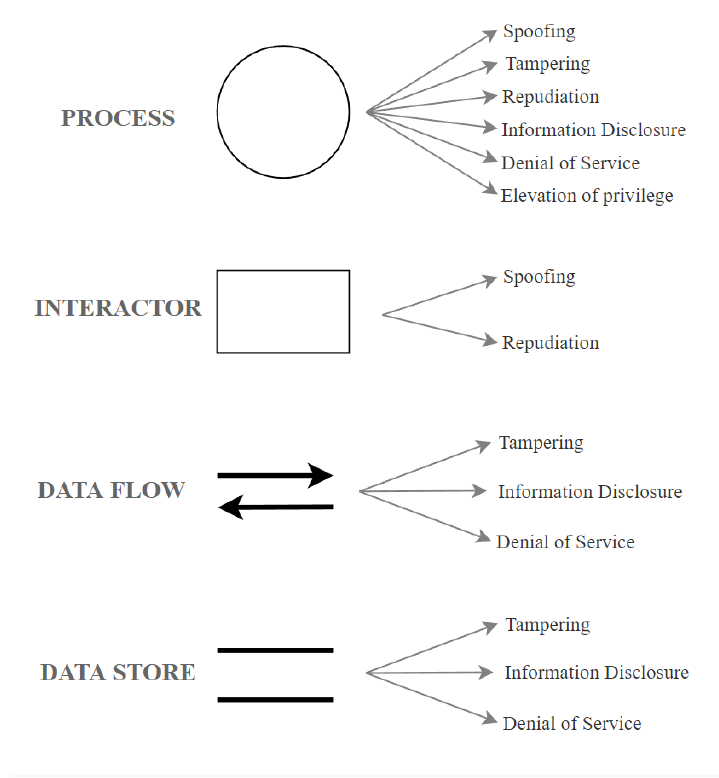
Figure 3. Threat Categories Per Component.